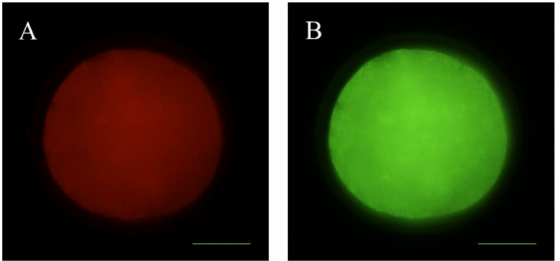
Figure 4. Representative images of JC-1 stained mitochondria in sheep oocytes. ( A ) Mitochondria with high membrane potential (red fluorescence); ( B ) mitochondria with low membrane potential (green fluorescence). Scale bar = 21 µ M.